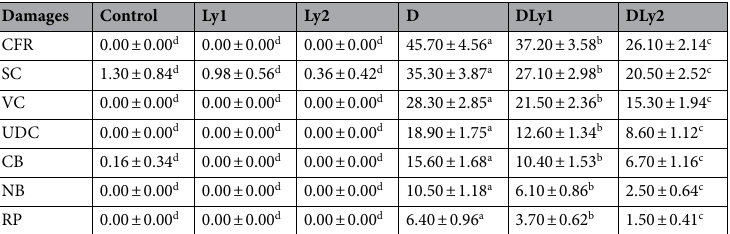
Table 2. Mitigative role of lycopene against genotoxicity induced by dithane. Control: tap water, Ly1: 215 mg/L lycopene, Ly2: 430 mg/L lycopene, D: 500 mg/L dithane, DLy1: 500 mg/L dithane + 215 mg/L chromosome, UDC unequally distributed chromatins, CB chromosomal bridge, NB nucleus bud, RP reverse polarization.